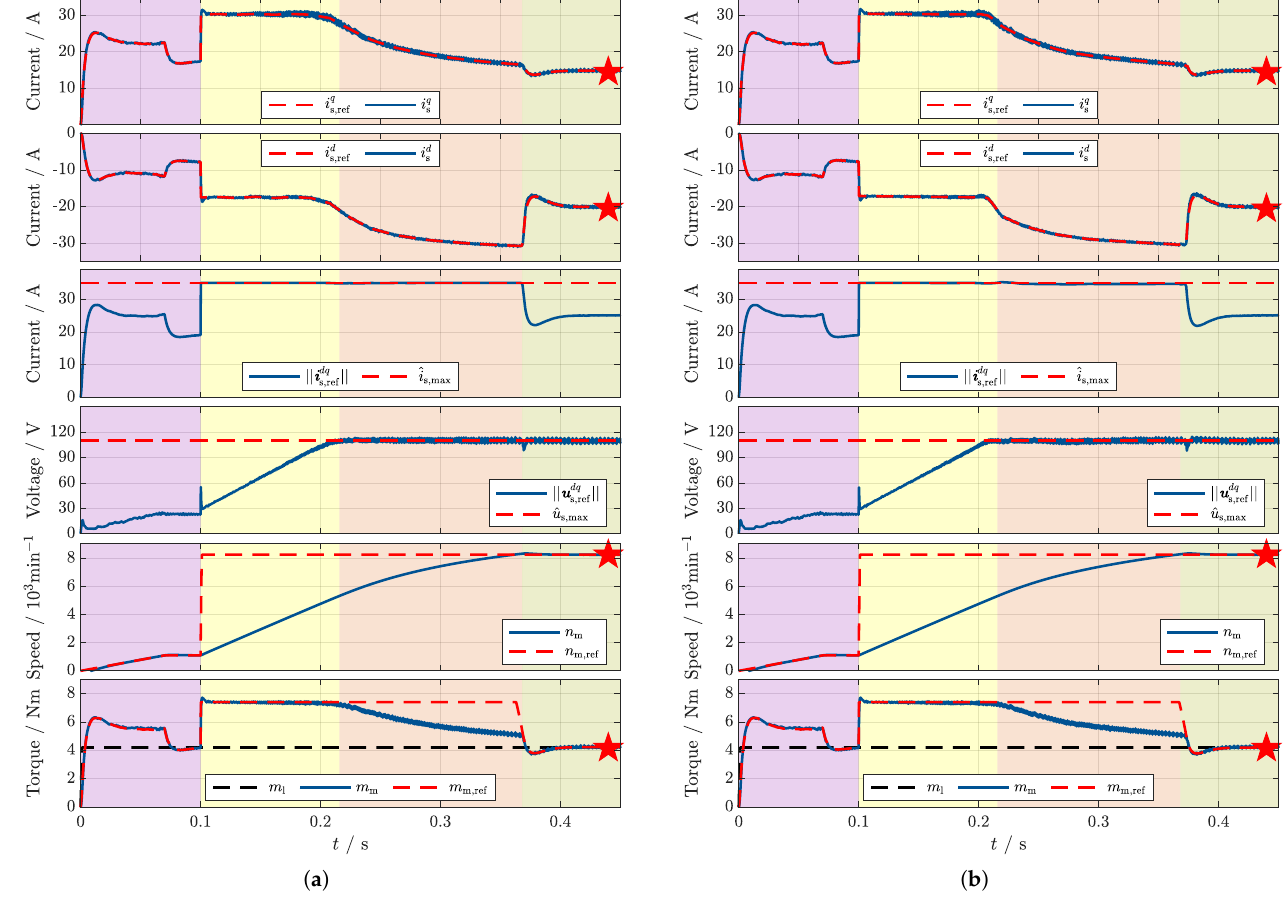
Figure 19. Implementation results: ( a ) OFTC with analytical ORCC (OFTC tion between all operation strategies (i.e., MTPL [ ], MC ext [ ], MC [ ] and FW [ ]) and ( b ) ANN-based OFTC (OFTC ANN